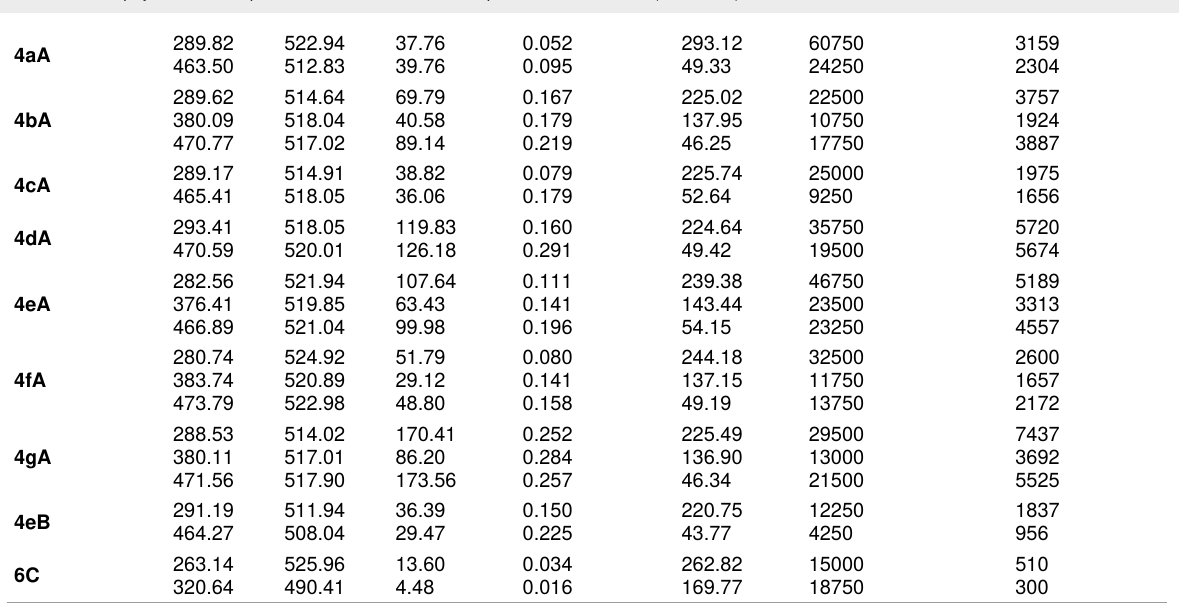
Table 2: Photophysical data of β -carboline-tethered benzothiophenone derivatives.